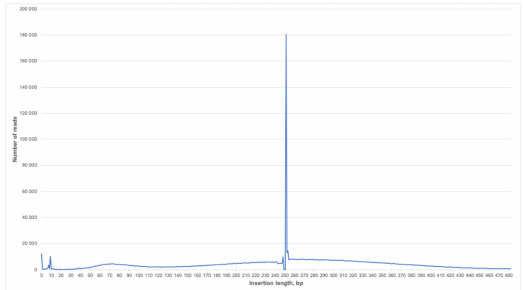
Figure 3. Insertion length distribution for PE reads of the smash library. The X axis is the insertion length in bp, and the Y axis is the number of reads of the corresponding